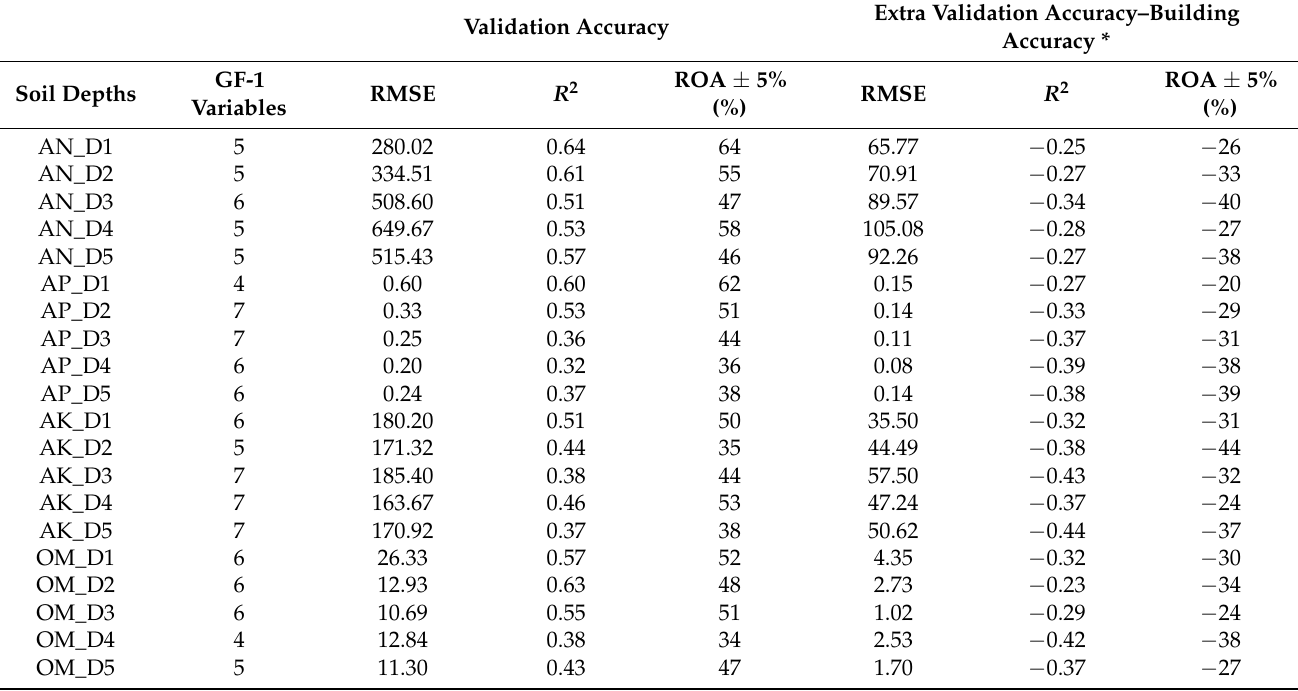
Table 5. Evaluation of model performances calculated from the extra validation area. Extra Validation Accuracy–Building Validation Accuracy